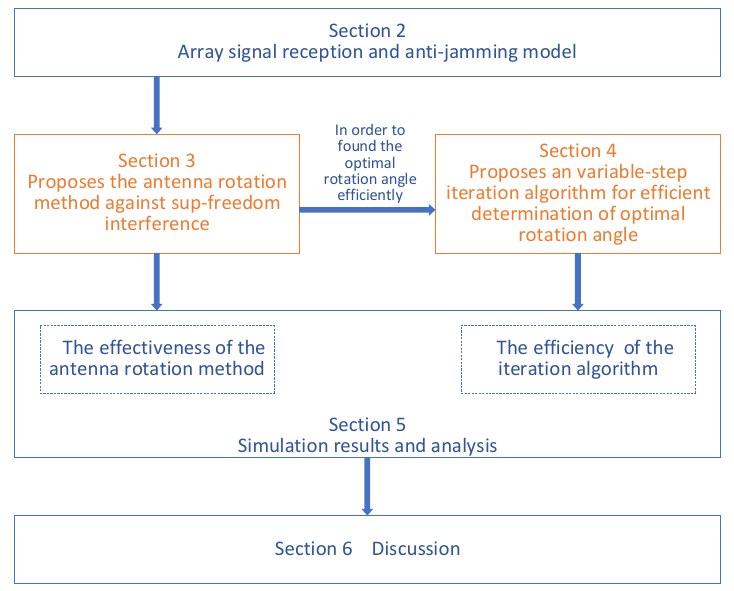
Figure 1. Block diagram of the work.